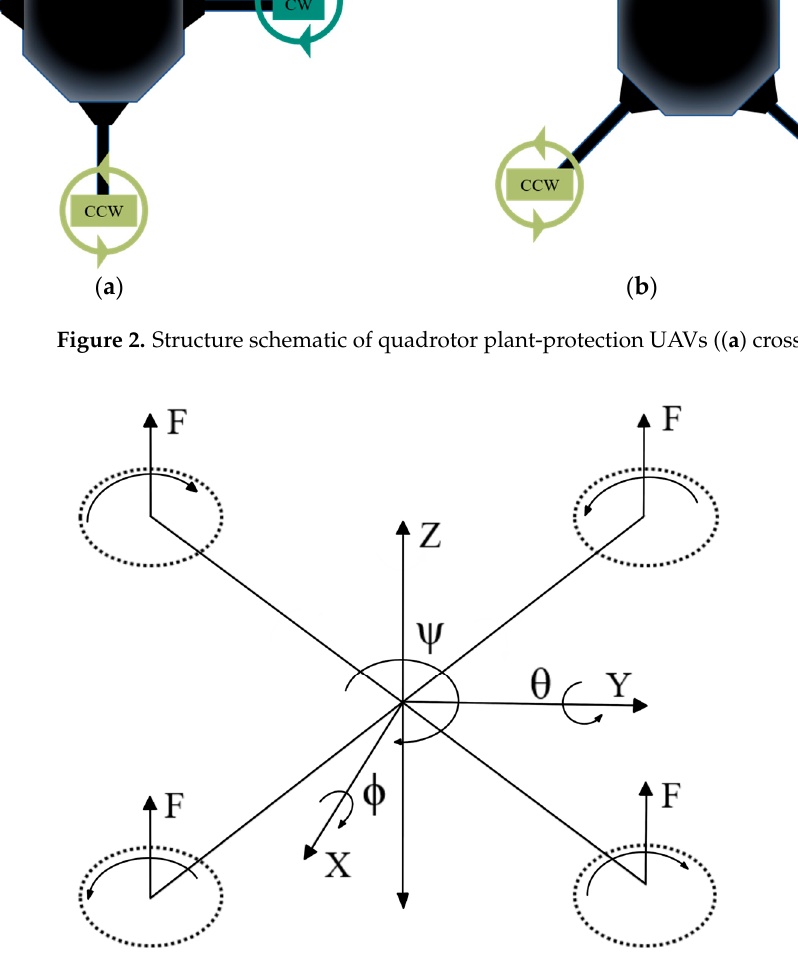
Table 2. UAV control methods.